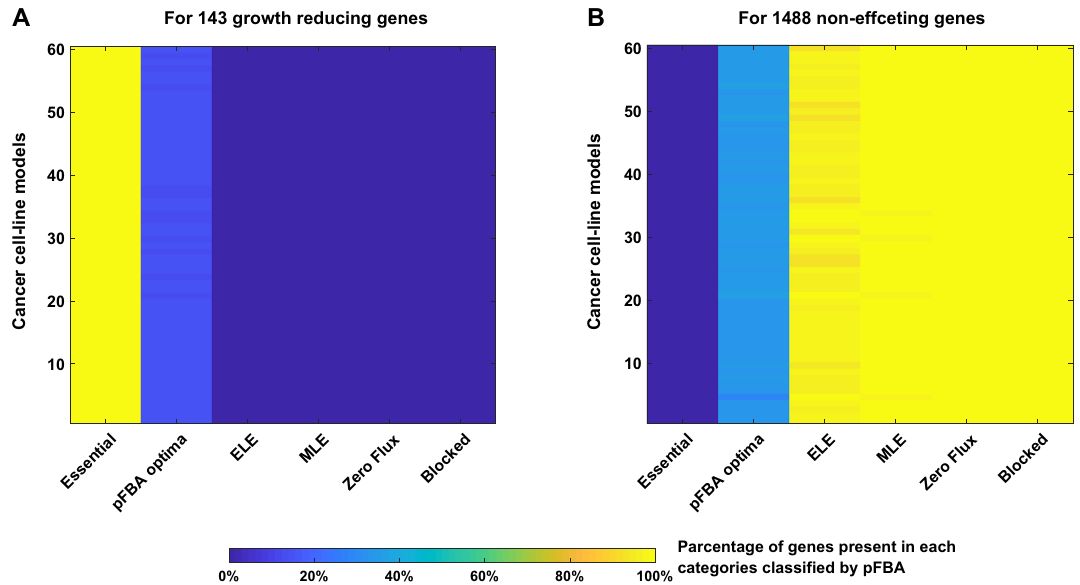
Figure 2. Coverage of pFBA classes by the 143 growth reducing and 1488 non-effecting genes set. For each of the 60 models, pFBA was applied to classify the genes into six categories and then the parentage of involvement for each class into the ( A ) 143 growth reducing genes set and ( B ) 1488 non-effecting genes set was